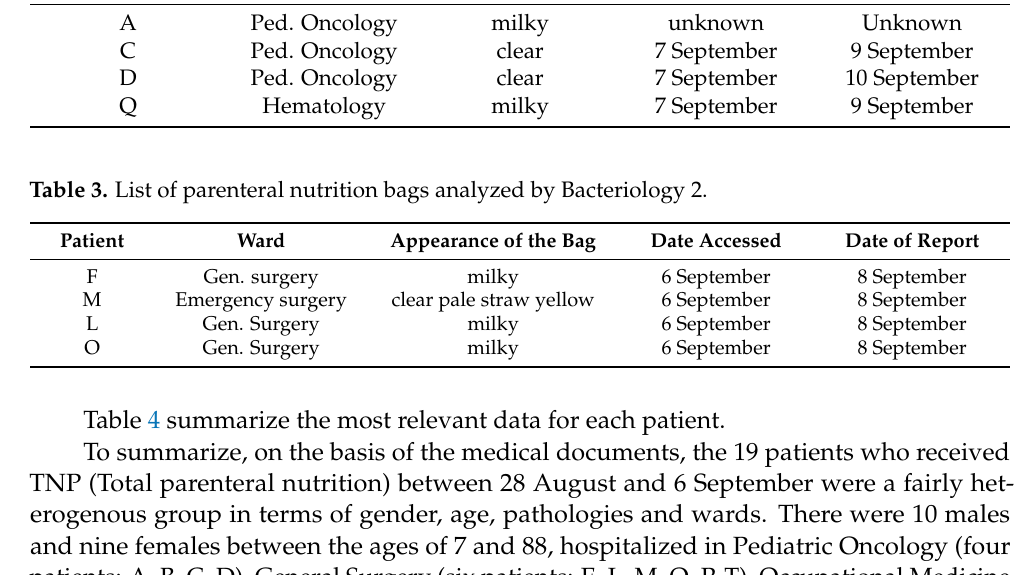
Table 2. List of parenteral nutrition bags analyzed by Bacteriology 1.